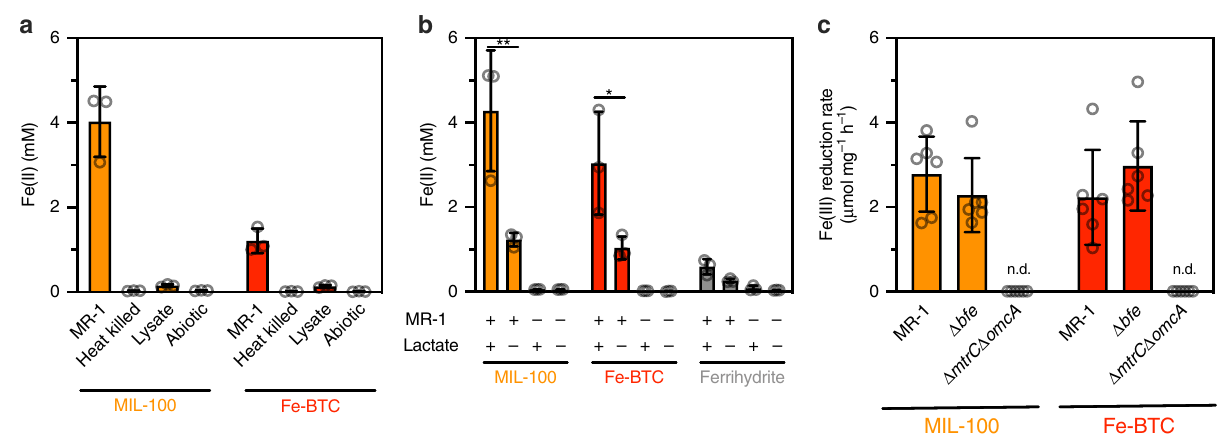
Fig. 3 Genetic and metabolic effects on reduction. a Fe(II) concentrations after 48 h in cultures containing either heat-killed, lysed, or whole-cell inocula of S. oneidensis MR-1 (inoculating OD = 0.002). Data shown are mean ± S.D. for three independent biological replicates. b Fe(II) concentrations after 48 h 600 for cultures of S. oneidensis MR-1 (inoculating OD 600 = 0.02) with 0 mM lactate or 20 mM lactate. + indicates the presence of either S. oneidensis MR-1 or lactate, while – indicates the absence of the components. Data shown are mean ± S.D. for three independent biological replicates. Three abiotic replicates are also shown. Statistical comparisons were made between lactate + and lactate – biotic samples using two-way ANOVA and Sidak ’ s post-test. * P = 0.0255, ** P = 0.0014. c Total protein normalized Fe(III) reduction rate of S. oneidensis MR-1 and knockout strains Δ bfe and Δ mtrC Δ omcA after 48 h. n.d. indicates that the rate could not be determined due to lack of detectable biomass. Data shown are mean ± S.D. for six independent biological replicates. Source data for a – c are provided as a Source Data fi le